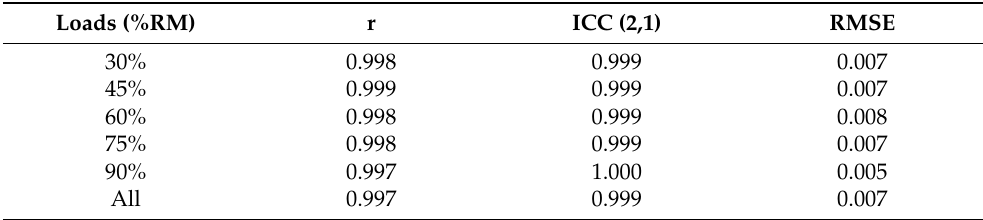
Table 2. Pearson’s correlation coefficient (r), ICC, and RMSE of eccentric mean velocity measured by the FRTMS and the OptiTrack system during different loads.